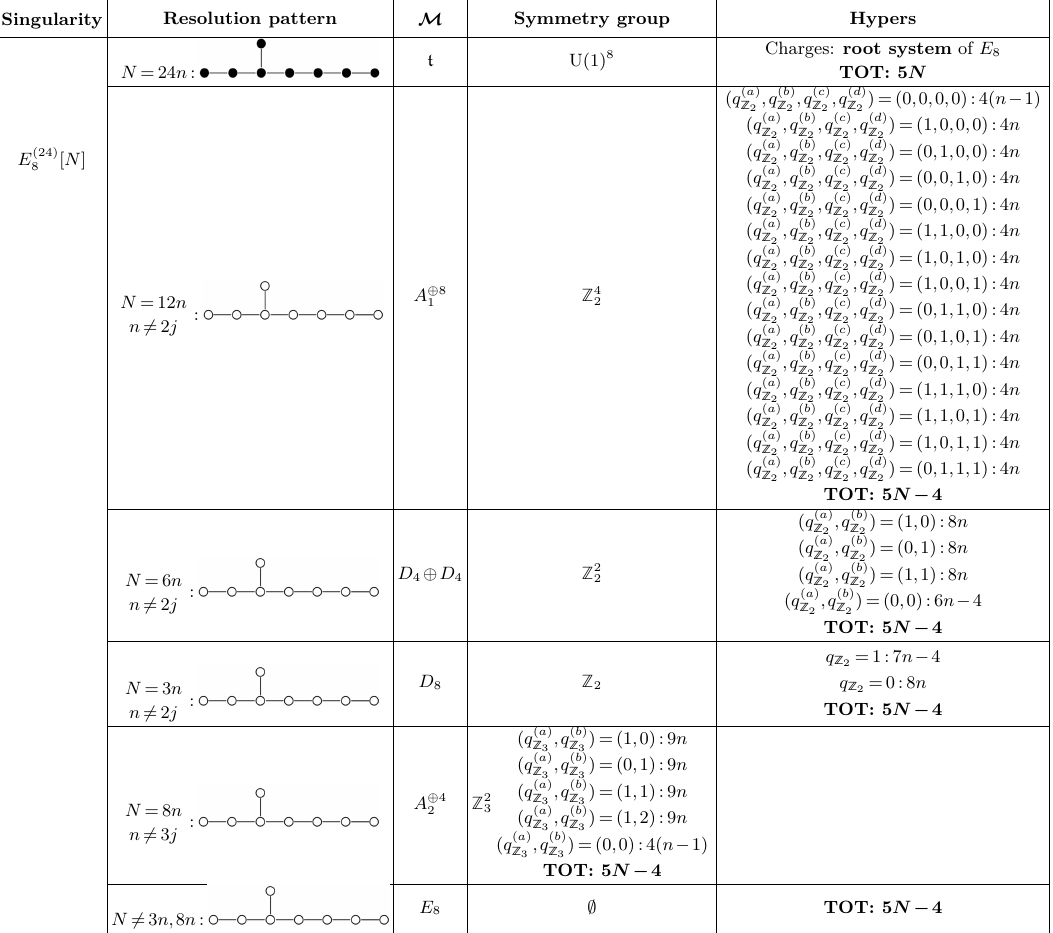
Table 9 . Higgs branch data for quasi-homogeneous cDV singularities of E (24)